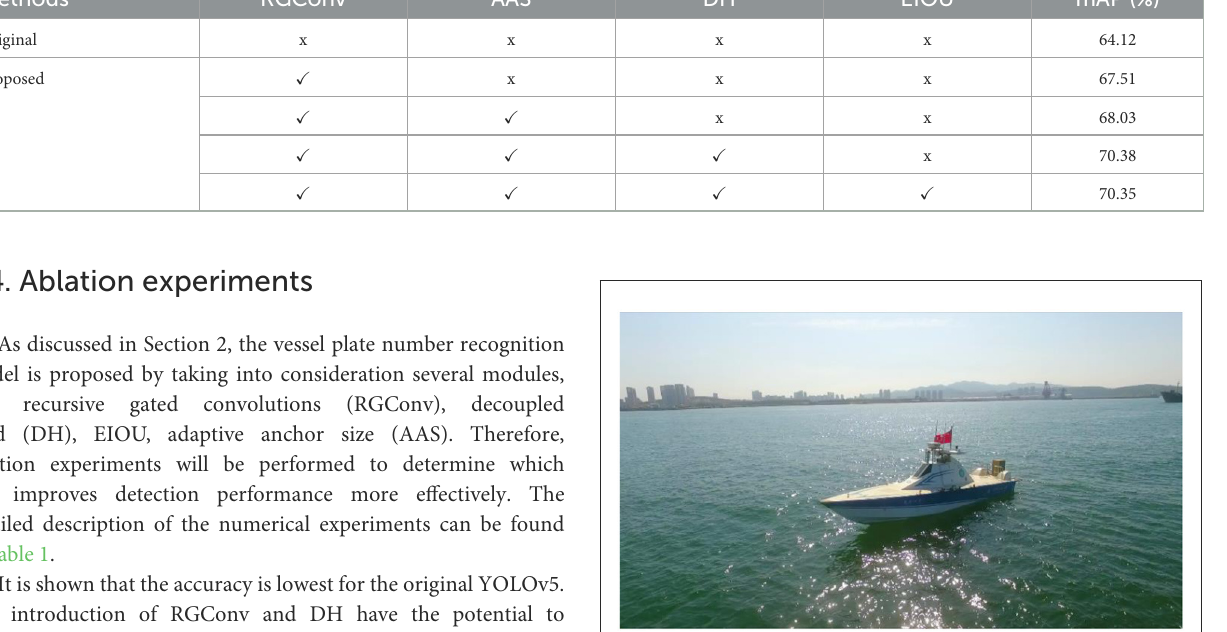
FIGURE9 “Tian Xing”